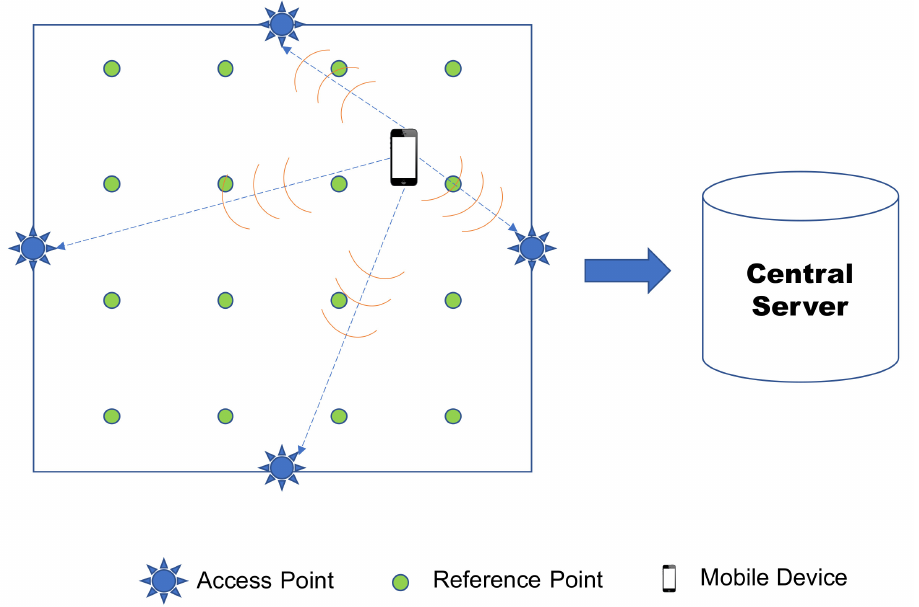
Figure 1. An example of a typical WLAN Indoor Positioning System (IPS)